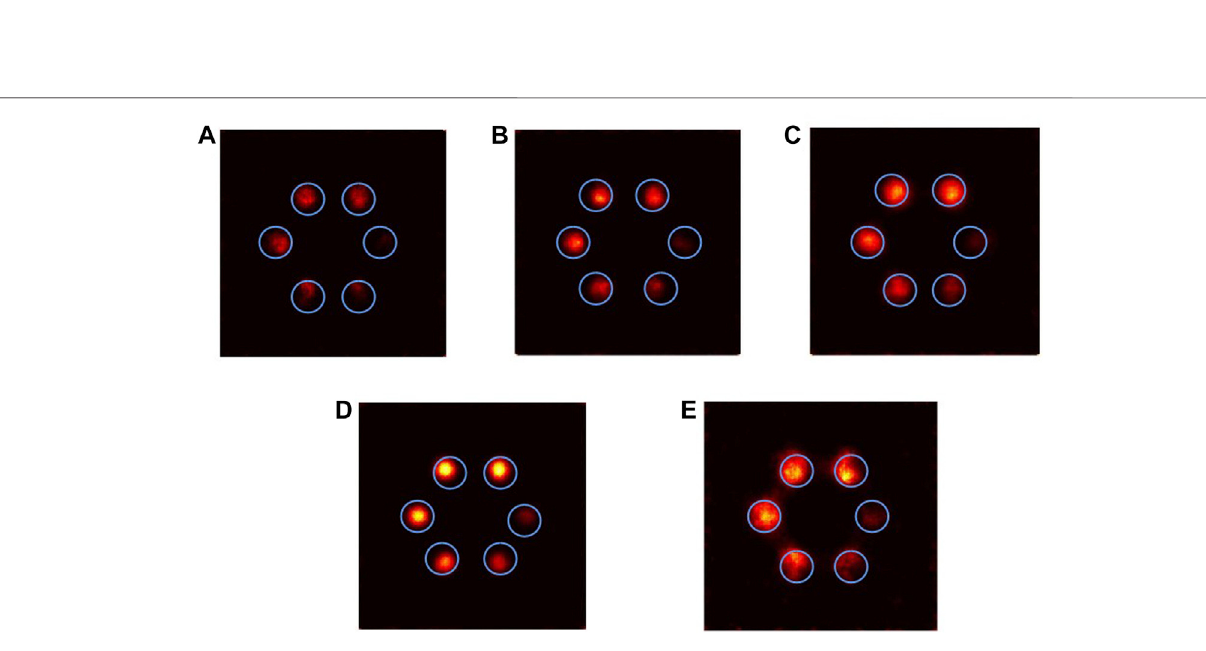
Frontiers in Physics |